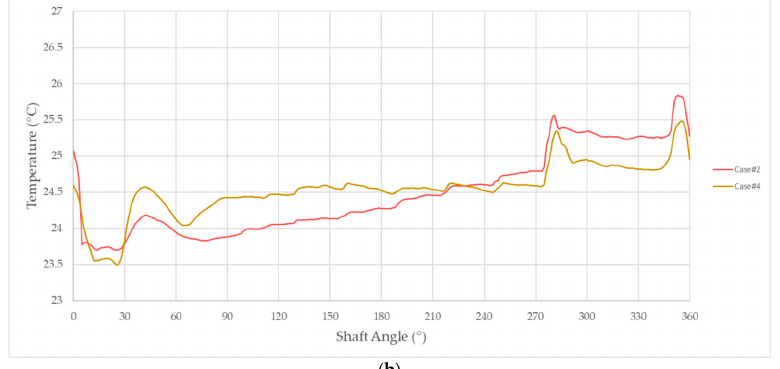
Figure 24. Temperature within a displacement chamber of the pump: ( a ) Case #2 and Case #3; ( b ) Case #2 and Case #4.